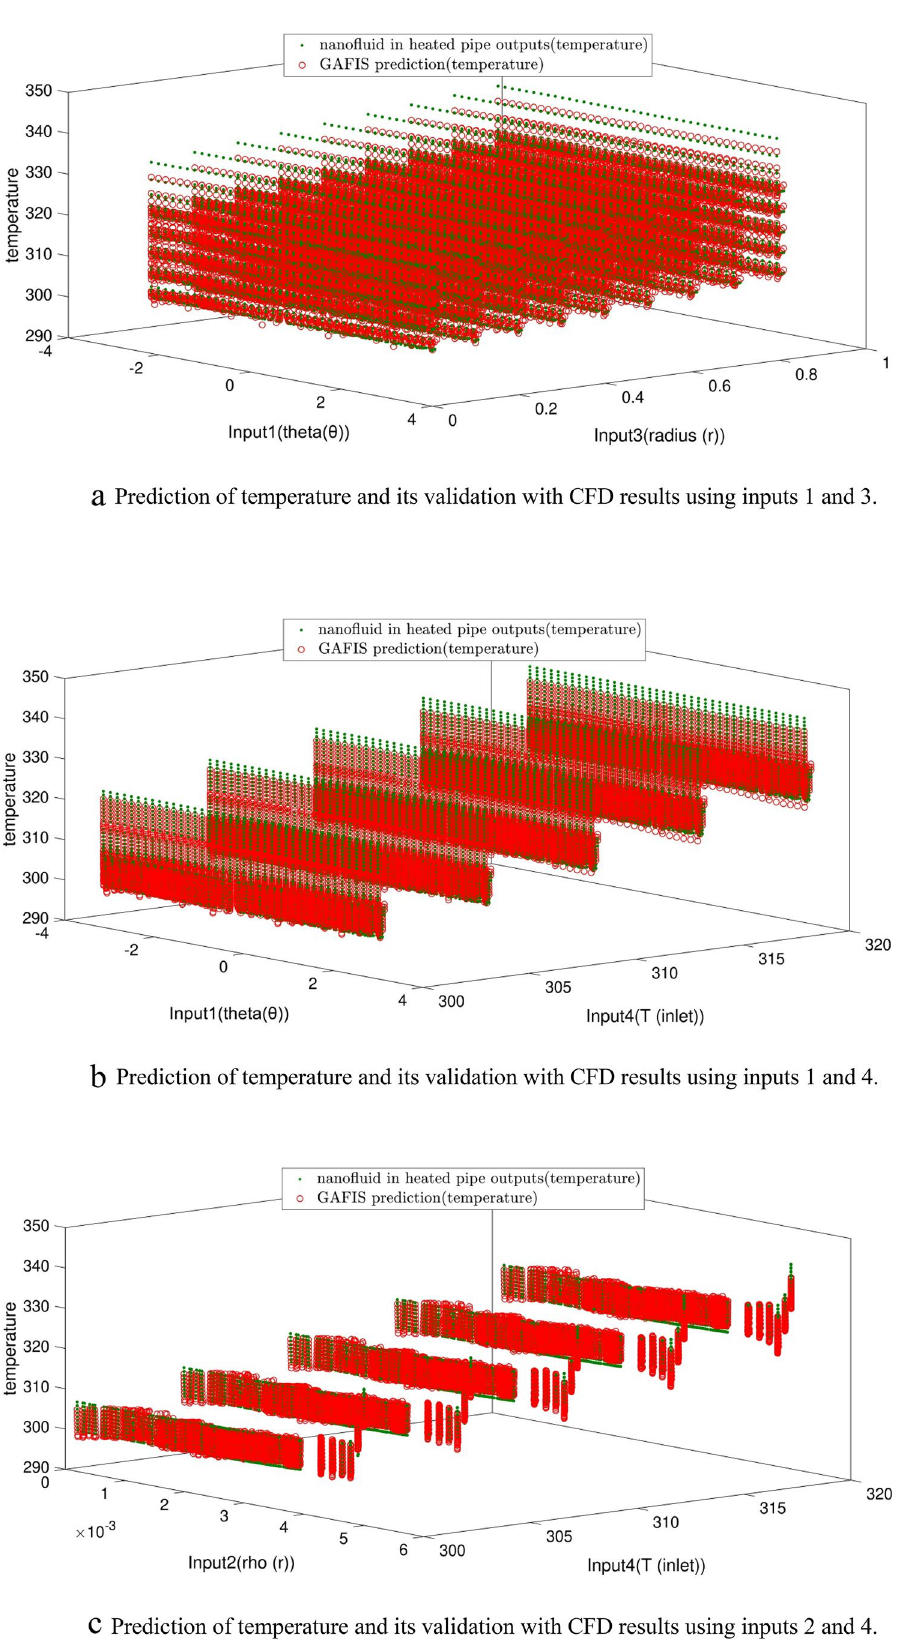
Figure 8. (a) Prediction of temperature and its validation with CFD results using inputs 1 and 3. (b) Prediction of temperature and its validation with CFD results using inputs 1 and 4. (c) Prediction of temperature and its validation with CFD results using inputs 2 and